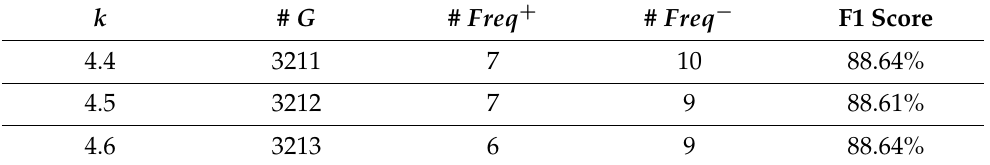
Table 12. Term distribution of [4.4, 4.5, 4.6] k for MARSA (Sport) using